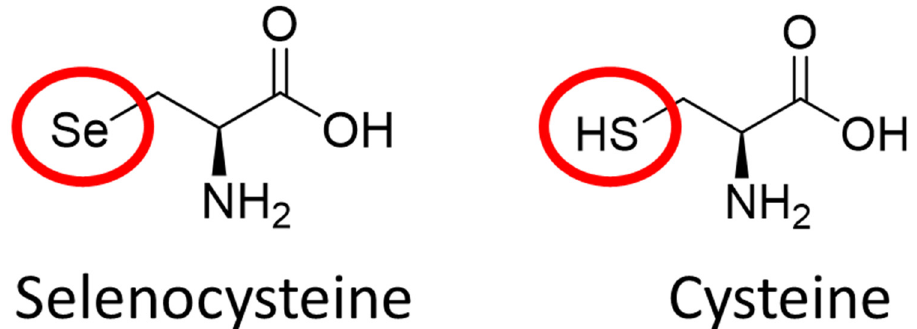
Figure 1. Chemical structure of selenocysteine and cysteine. The two compounds differ by a single atom, a selenium atom in selenocysteine and a sulfur atom in cysteine. The presence of selenium improves the redox properties of a given protein (e.g., GPX family, thioredoxin reductase, selenoprotein P).